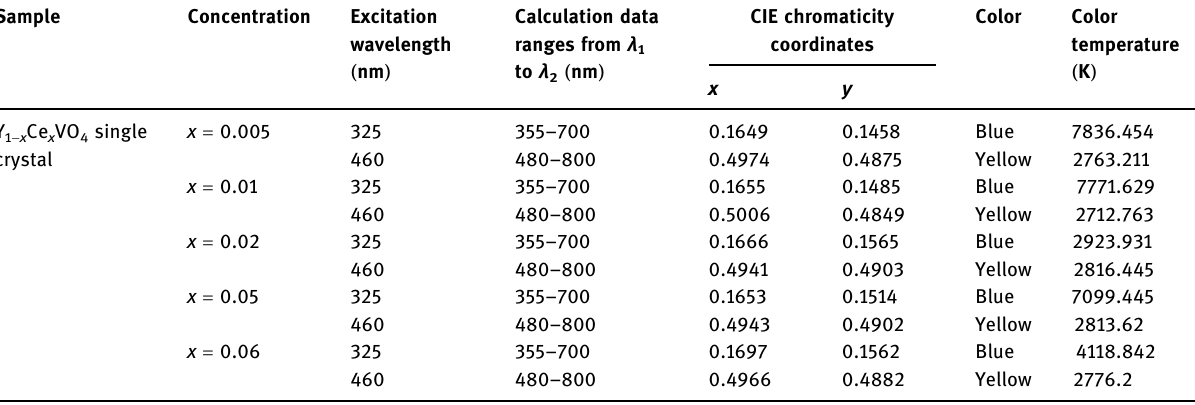
Table 2: CIE chromaticity coordinates and color temperature of Ce 3 + - doped YVO 4 single crystal excited at 325 and 460 nm, respectively